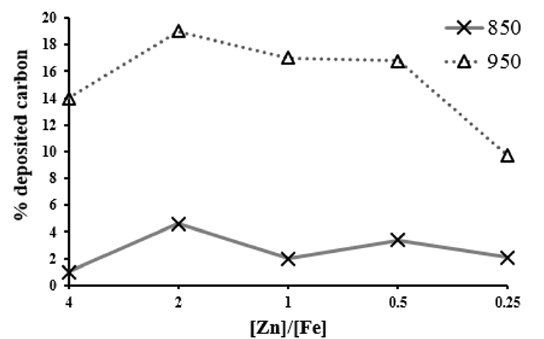
Fig. 8. Diagram of the weight loss percent of resulted carbon nanotubes using catalysts with the [Zn]/[Fe] proportion of 4, 2, 1, 0.5 and 0.25 at reaction temperatures of 850 and 950 °C.